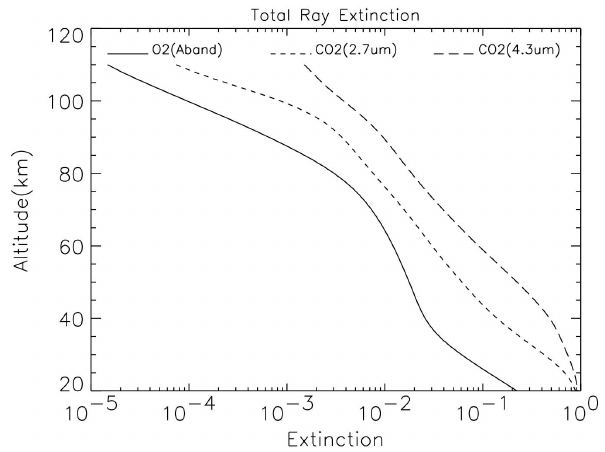
Fig. 3. F LU – Sensitivity of 4.3µm CO 2 limb path extinction to 1K change at the tangent altitude, keeping layers below fixed. F L D – Sensitivity to 1K change at the tangent point, keeping layers above fixed. F – Sensitivity to 1K change in all layers at or above the tangent altitude, keeping layers below fixed. B – Sensitivity due to temperature used for line strength and broadening. H – Sensitiv- ity due to impact on hydrostatic pressure (hydrostatic equilibrium maintained at all altitudes). I – Sensitivity due to impact of the ideal gas law. Sensitivity is defined as the fractional change of broadband extinction through a perturbed atmosphere relative to unperturbed. In the case of F , the perturbation is a 1K change to all layers from the tangent point upwards. For all others, the perturbation is a 1K change to the tangent layer